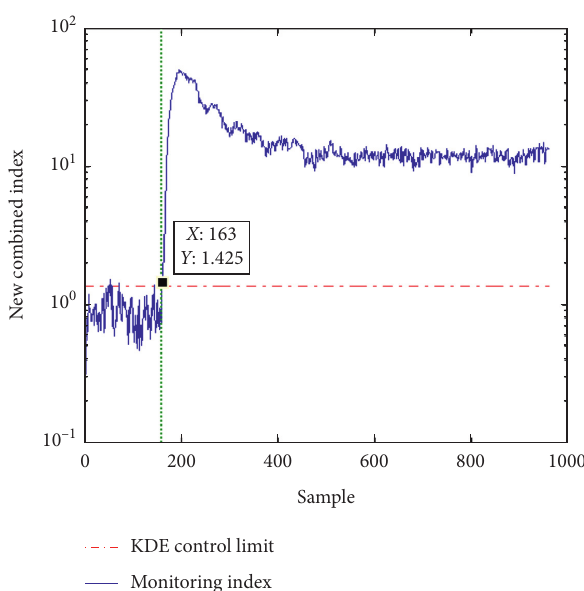
Figure 3: Monitoring index for fault